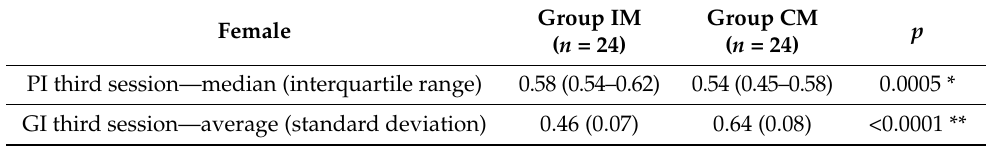
Group IM Group CM p ( n = 24) ( n = 24)